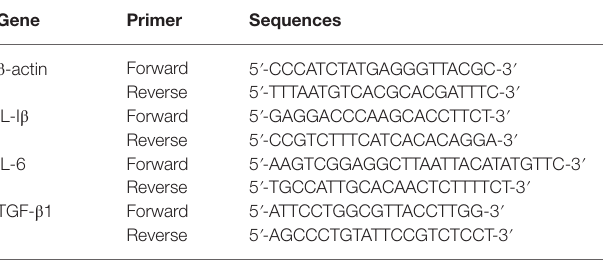
TABLE 1 | Primer sequence for